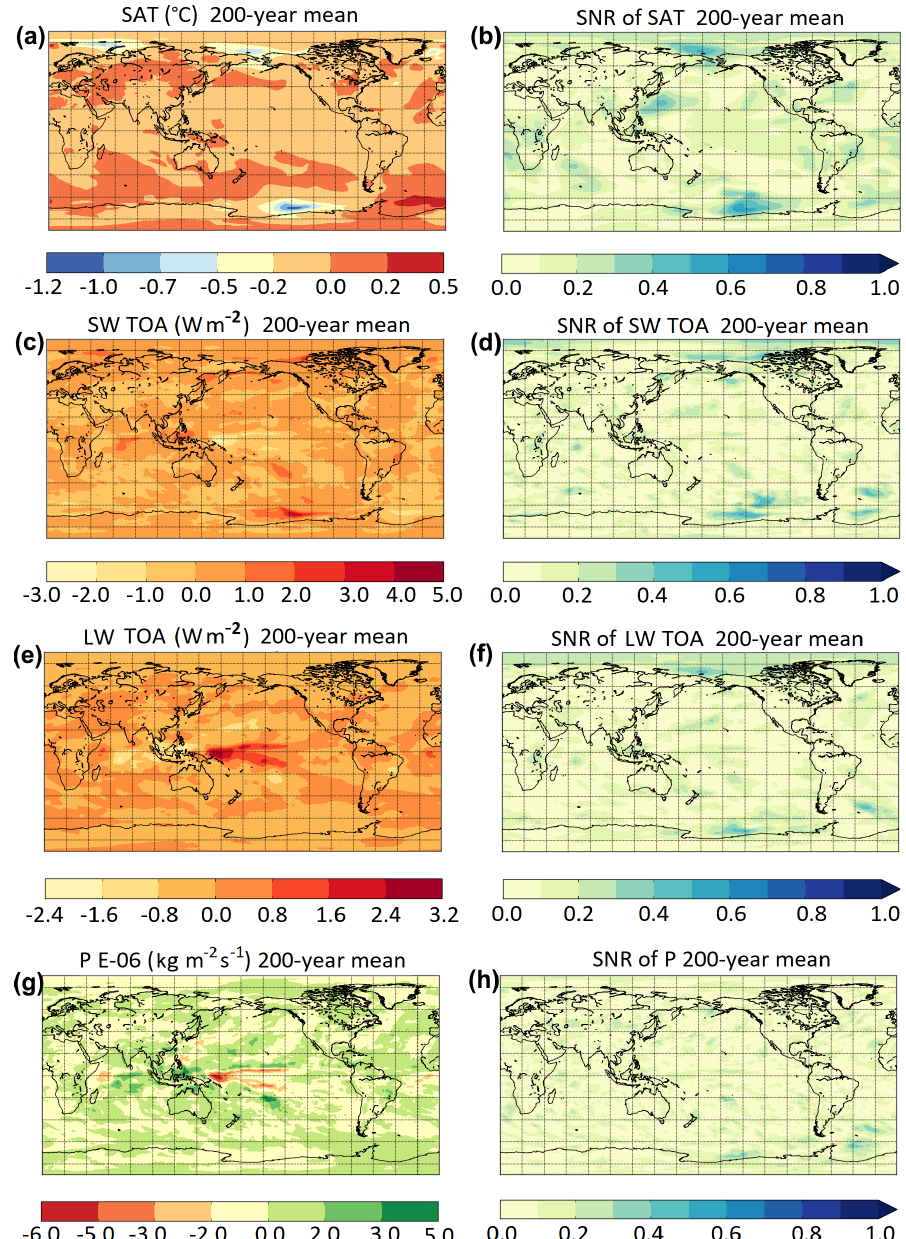
Figure 3. The 200-year means and corresponding SNR of (PI MO − PI AR ) differences for SAT (a, b) , SW TOA (c, d) , LW TOA (e, f) , and P (g, h)